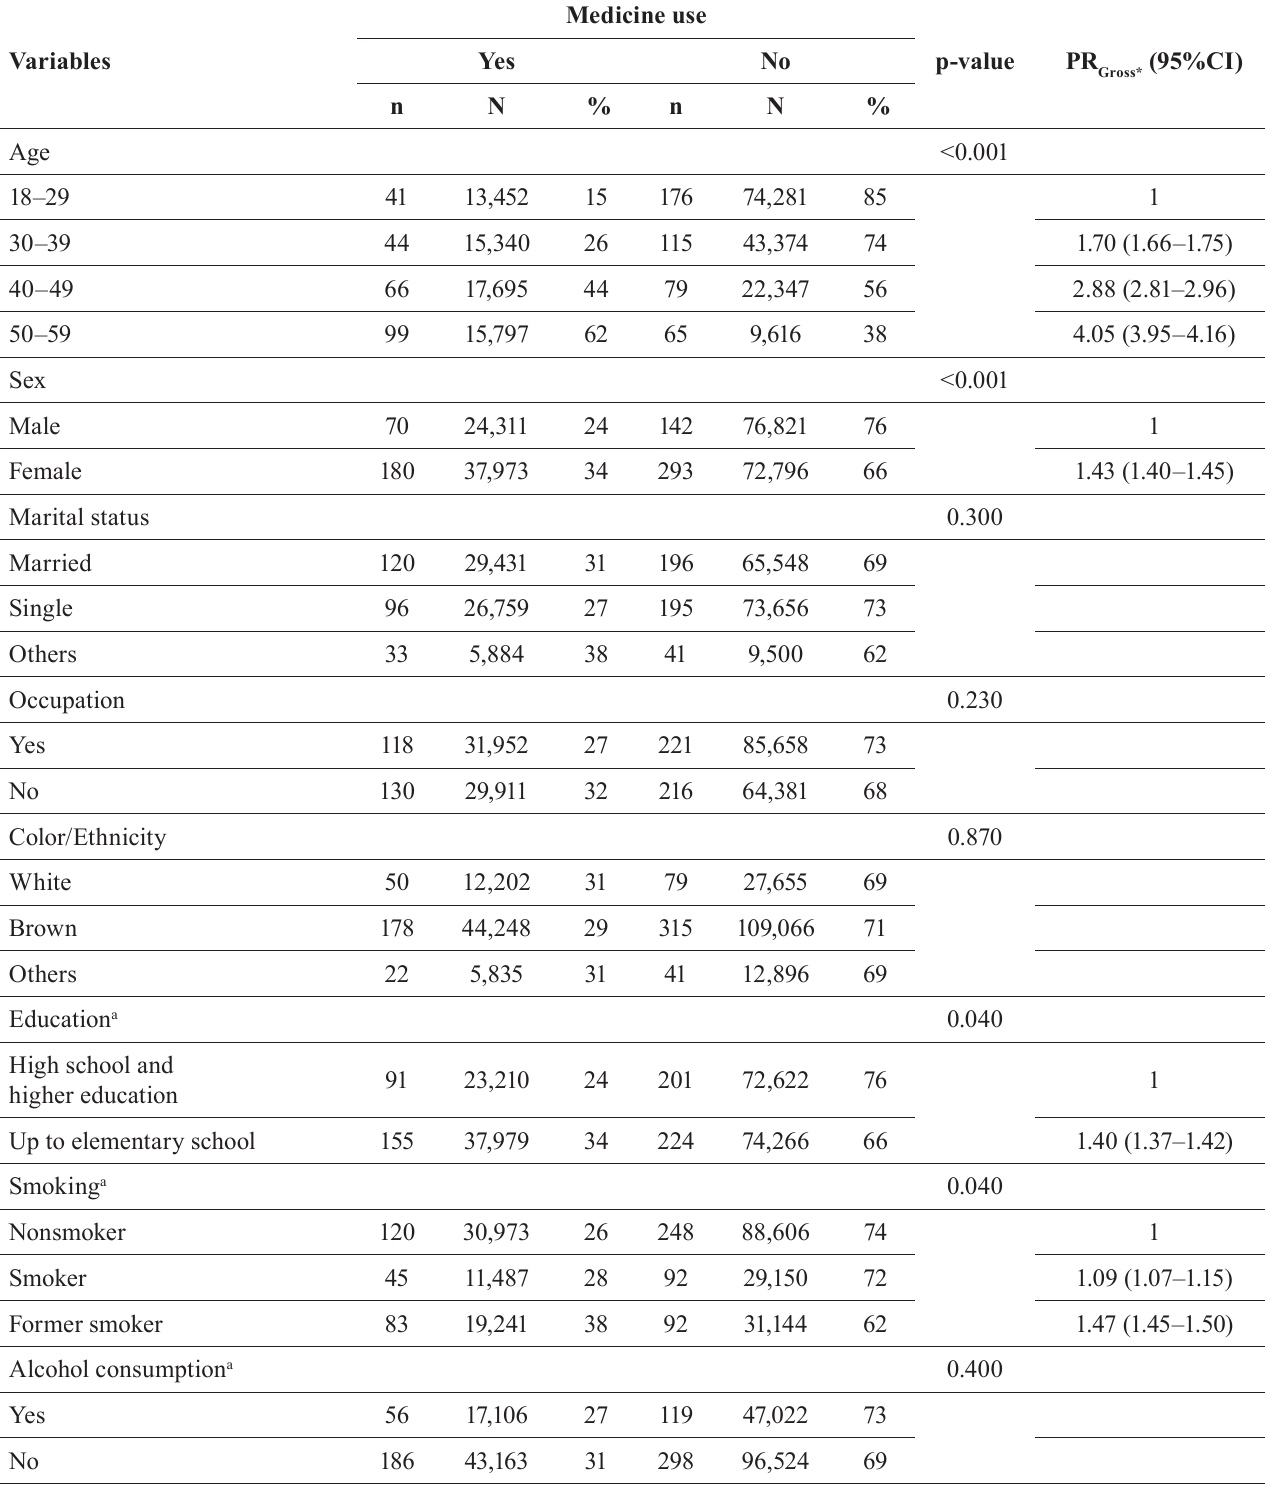
TABLE II - Prevalence and gross prevalence ratio of medicine use according to socioeconomic and demographic variables of the adult population in Rio Branco, AC, Brazil, 2014